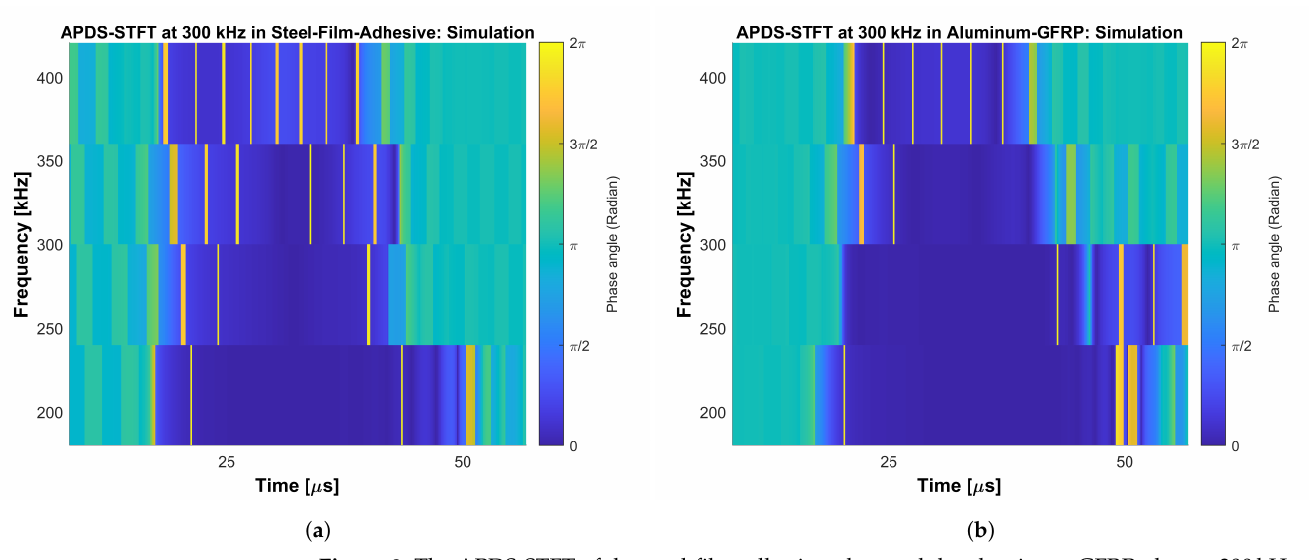
Figure 8. The APDS-STFT of the steel-film adhesive plate and the aluminum-GFRP plate at 300kHz: the S 0 -mode is identified (blue area in the middle) and an area of a phase shift of π shows at the end of the time axes. ( a ) APDS-STFT of the steel-film adhesive plate at 300kHz. ( b ) APDS-STFT of the aluminum-GFRP plate at